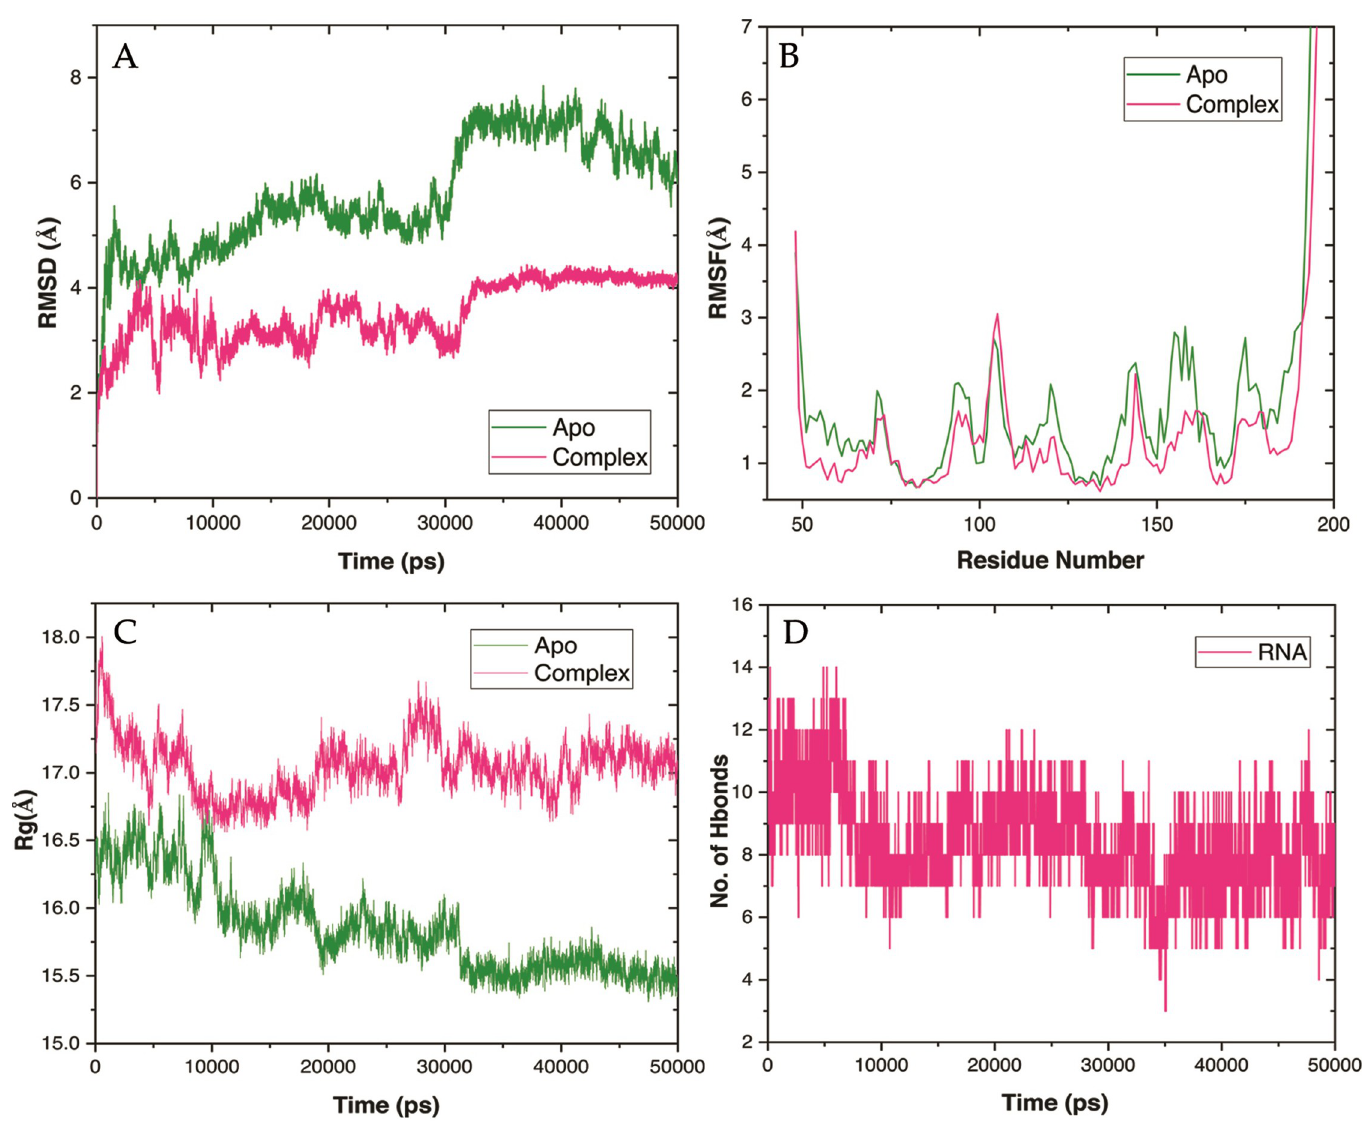
Fig 7. Conformational stability of YBMV CP of apo and complex through MD simulation. (A) Backbone RMSD ( B ) C-alpha RMSF YBMV CP ( C ) Radiation of gyration for YBMV CP; ( D ) Hydrogen bond analysis over 50 ns period concerning the index of the residue.